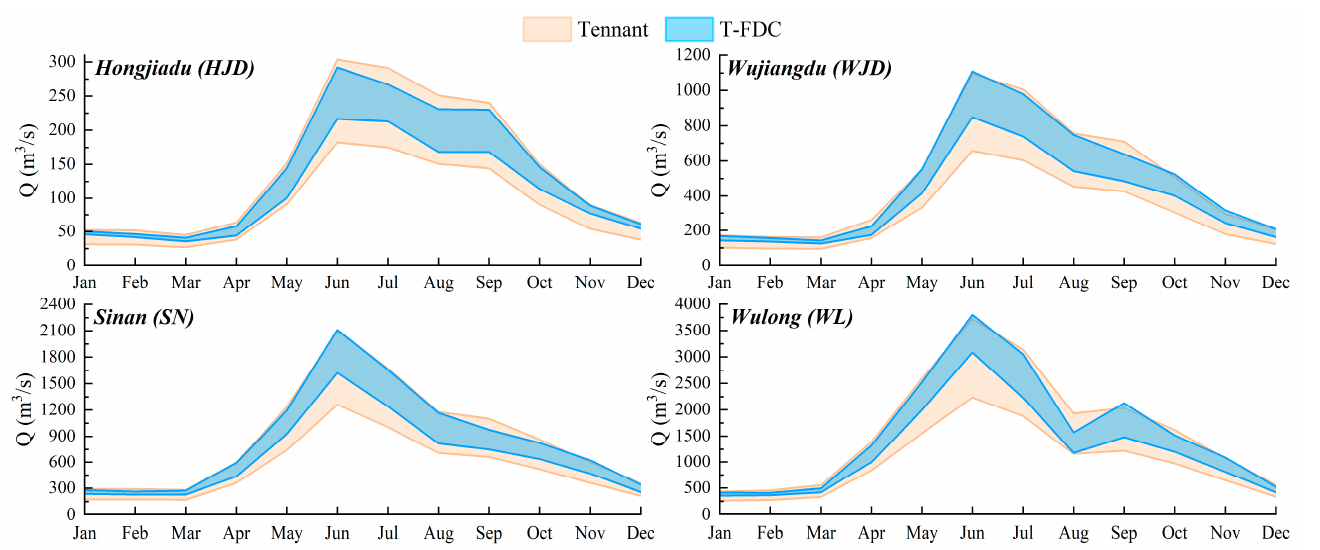
Figure 6. Optimal environmental flow calculated by two methods.